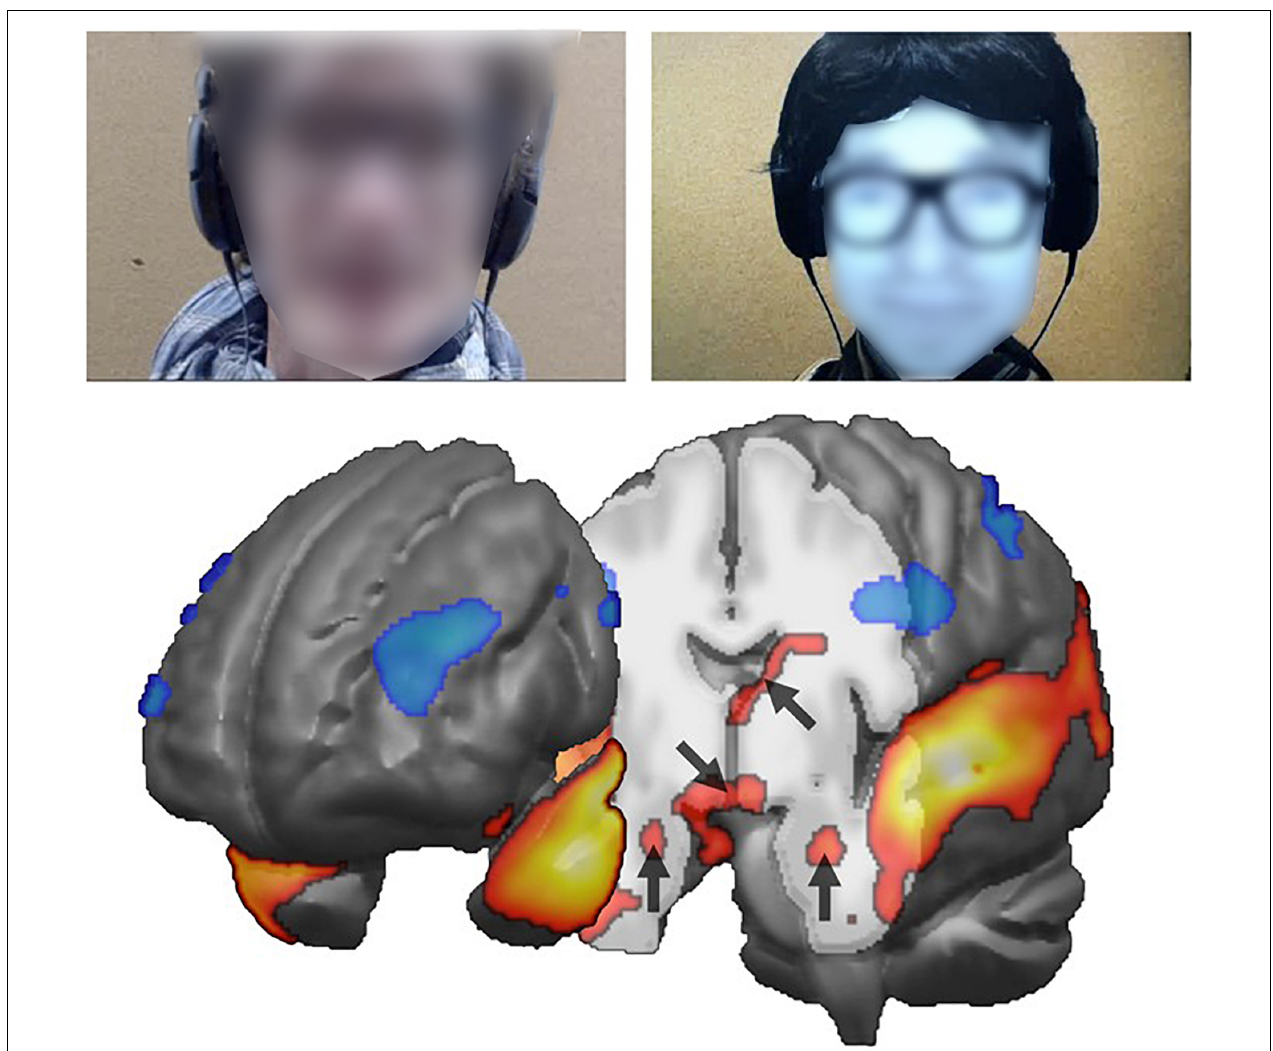
FIGURE 3 | Comparing conversation with human vs. robot ( top : extract from video) yields increased activity in subcortical structures, namely (arrows on the brain cut-off below, from top to bottom ) the right caudate nucleus, the hypothalamus and the amygdala